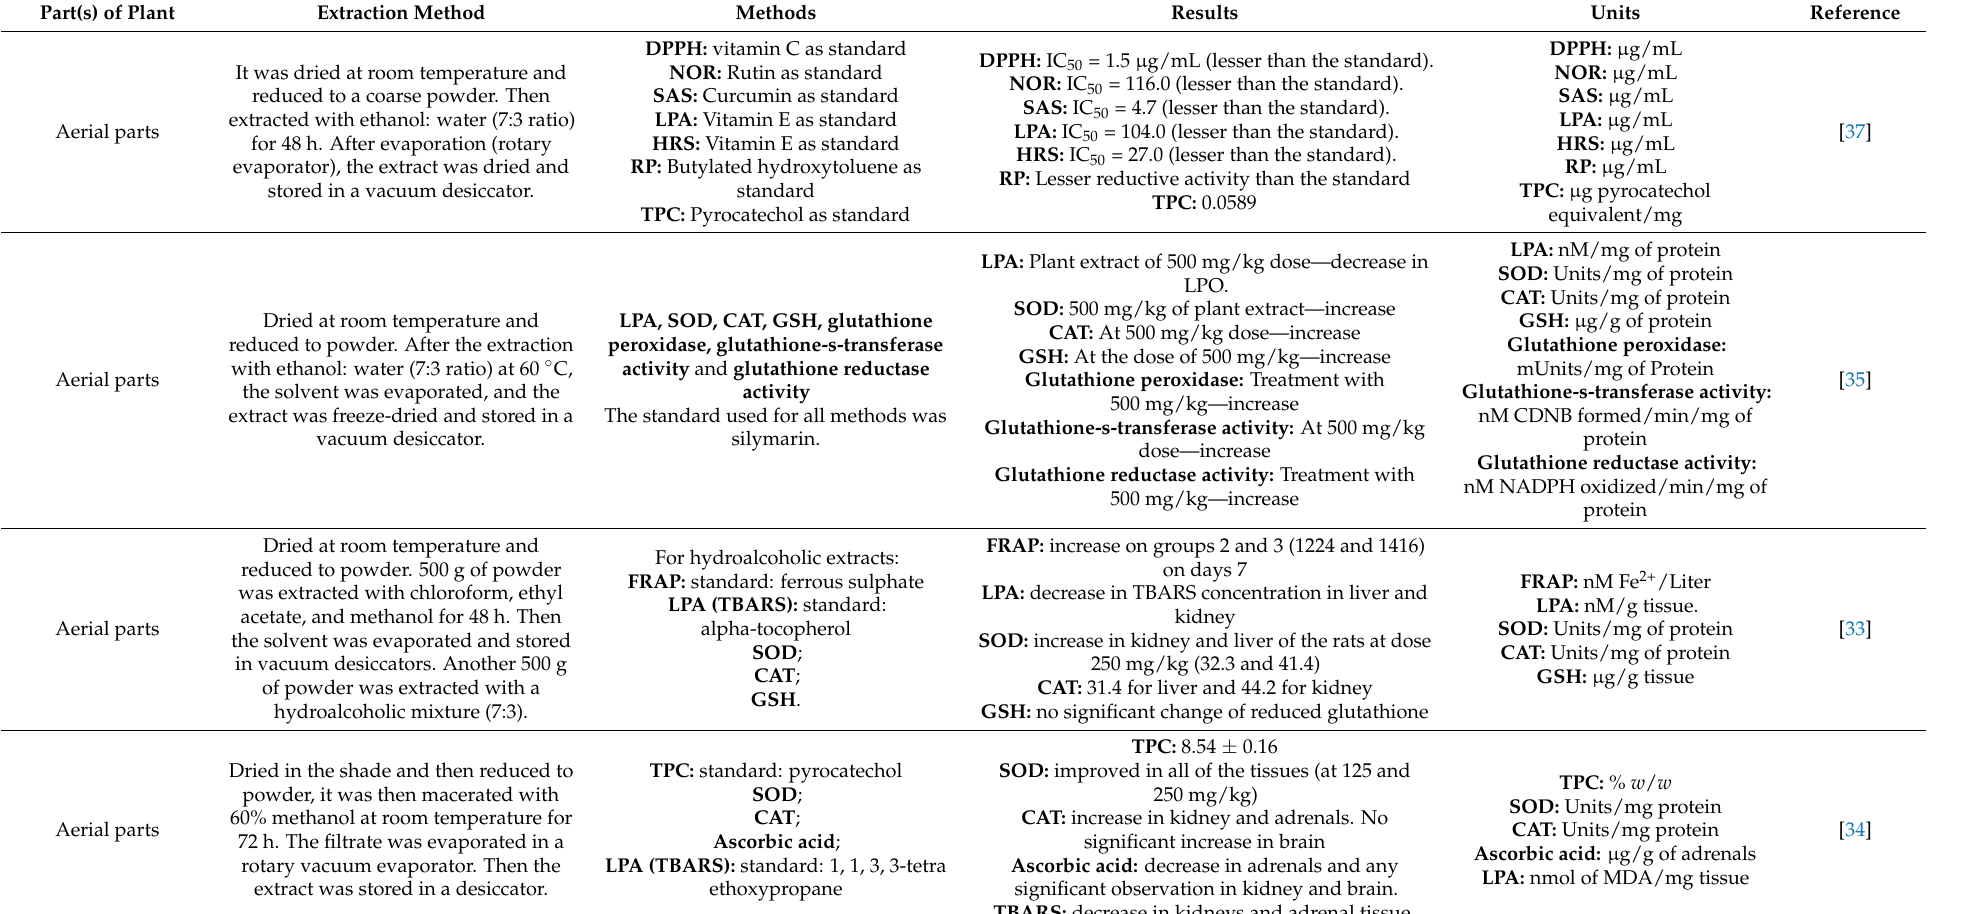
Table 1. Summary of studies conducted on antioxidant activity using C. scoparius